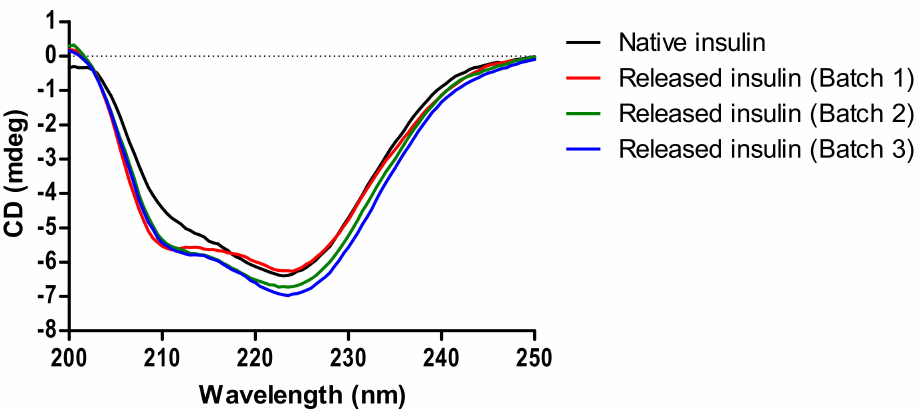
Figure 3. CD spectra of native insulin and bead-released insulin in SIF from three independent batches. Solutions were diluted to 10 µ